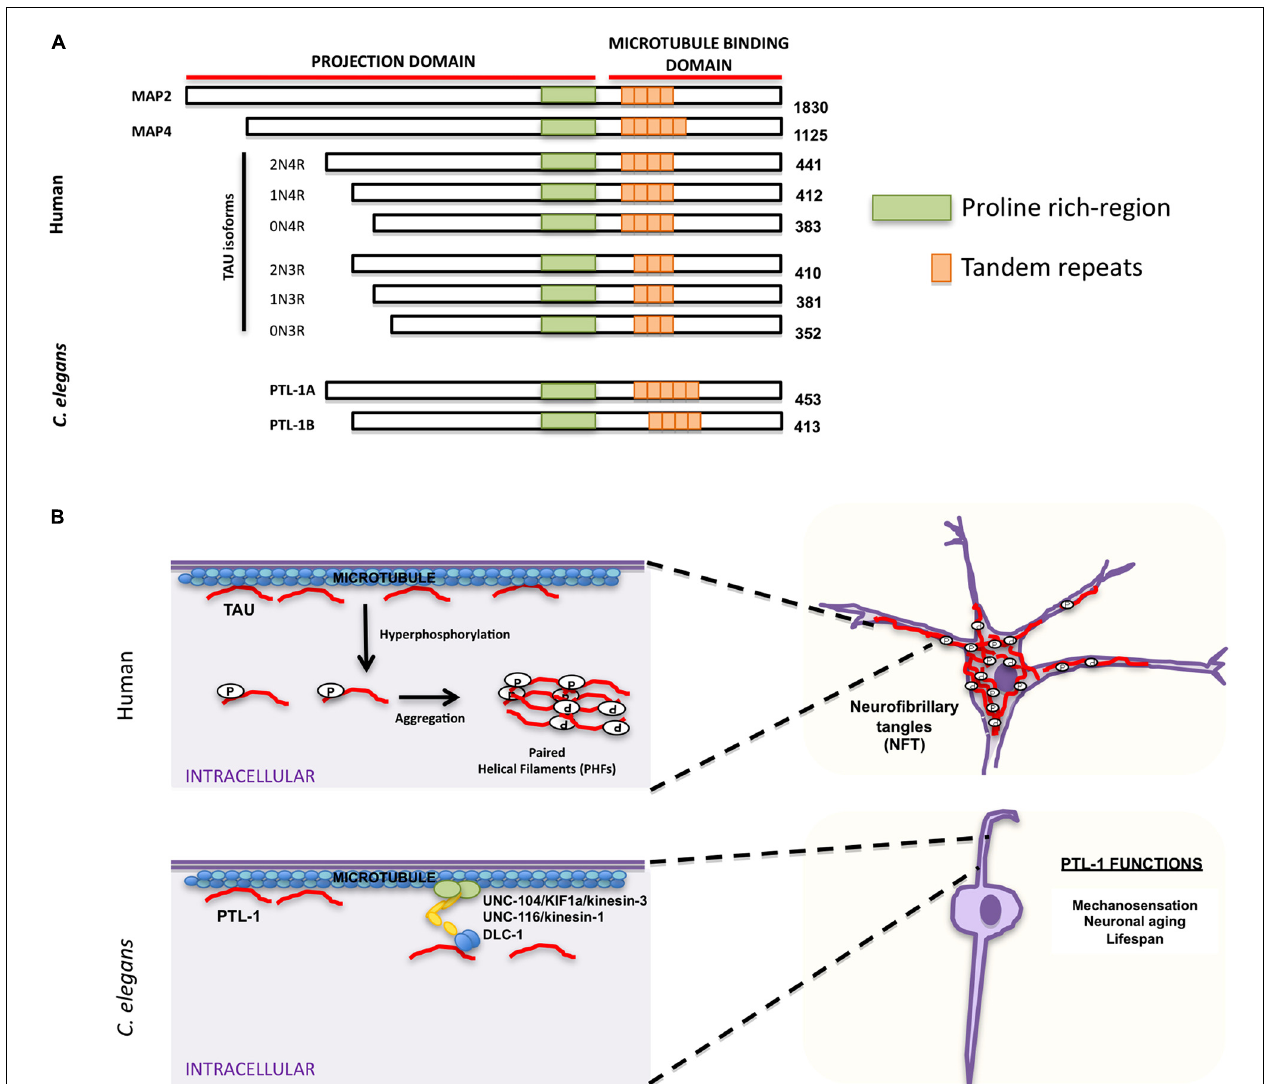
FIGURE 3 | Similarities and differences between human tau and Caenorhabditis elegans PTL-1. (A) Schematic representation of human microtubule binding proteins (MAPs) family, including tau isoforms and C. elegans PTL-1 isoforms. (B) Comparison between tau functions in humans (top) and C. elegans PTL-1/tau functions (bottom). Top .Tau has a physiological role in promoting and maintaining microtubule stability. In pathological